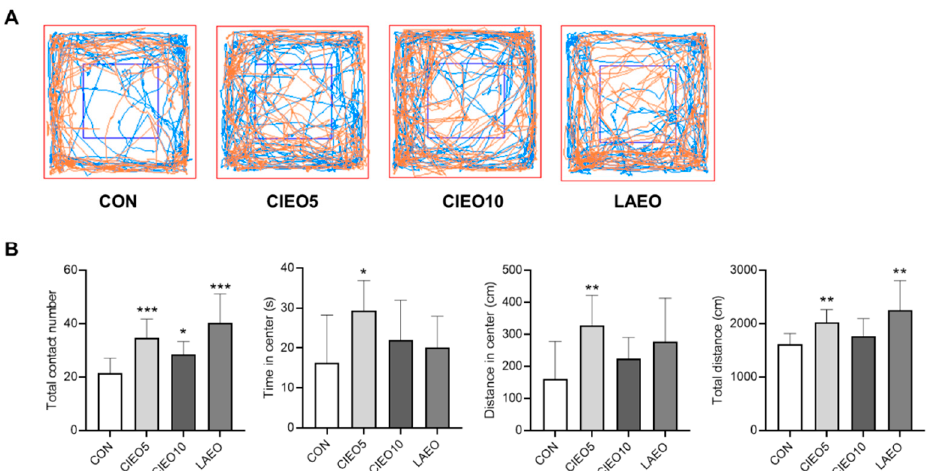
Figure 3. Effect of CIEO on social behavior in mice. ( A ) Traveling paths in the social interaction test. ( B ) The total contact number, time spent in the center, distance traveled in the center, and total distance were recorded in a 5-min session. Data represent means ± SDs ( n = 8 per group). * p < 0.05, ** p < 0.01, *** p < 0.001 vs. the CON group. CON: control; CIEO: cinnamon essential oil; LAEO: lavender essential oil.